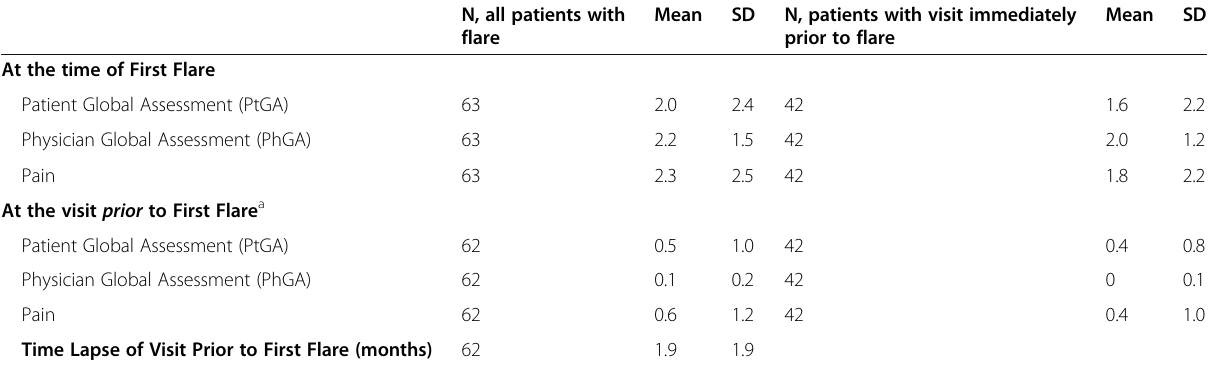
Table 2 Flare visit and prior visit